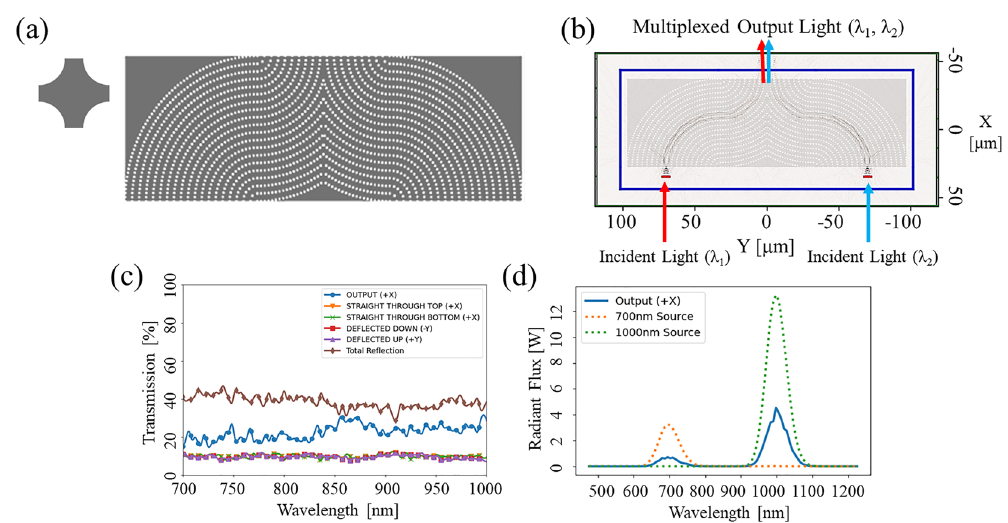
Figure 6. 2D simulation results from FDTD simulations in MEEP for OR logic gate. ( A ) Unit cell and full OR logic gate using SVPC design with spatial variation following 90-degree bend. ( B ) Propagation of light through SVPC for OR logic gates. ( C ) Transmission properties for SVPC in NIR spectrum. ( D ) Energy of two distinct wavelengths